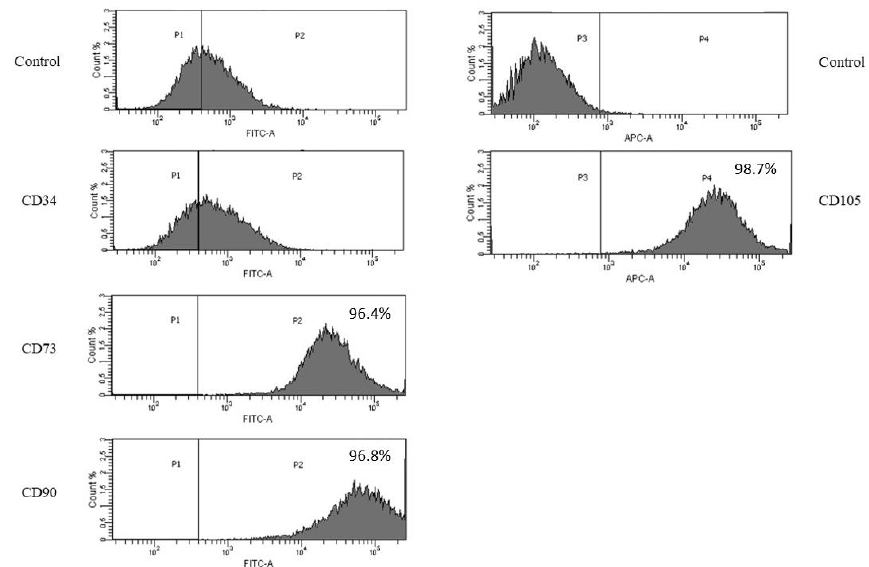
Figure 2. Flow cytometric analysis of MSC makers. Bone marrow MSCs were found to be positive for the MSC markers: CD73, CD90 and CD105 and negative for the endothelial marker: CD34.